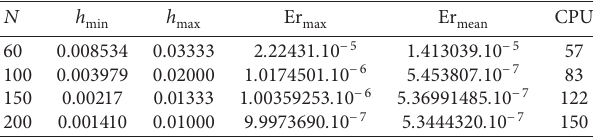
Figure 13: The δ � 0 . 01, and max ( u ) � 2450. − ziti solution with ε ap Figure 15: The δ t � 0 . 01, after 345-time iteration, − ziti solution at using the Cartesian discretization. Table 6: The committed error at t � 0 .